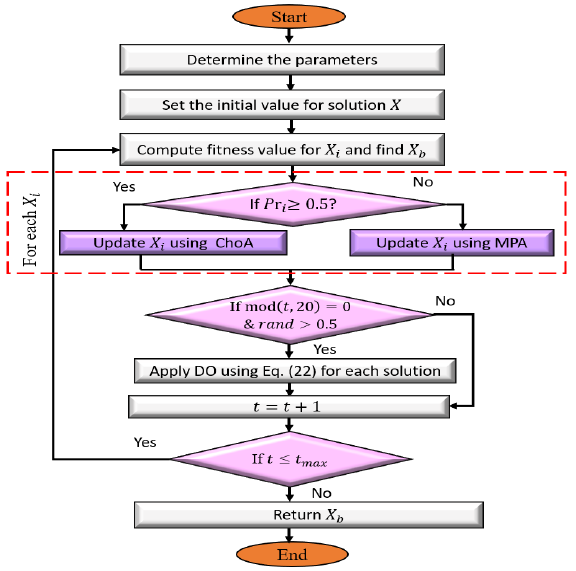
Figure 2. Developed CHMPAD